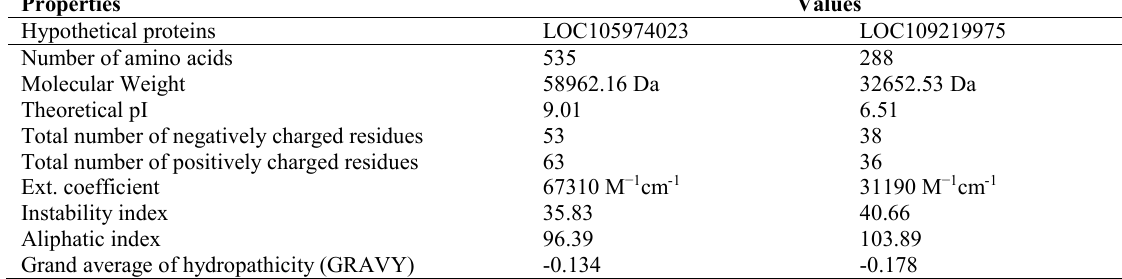
Table 1 . Physicochemical properties of the hypothetical proteins